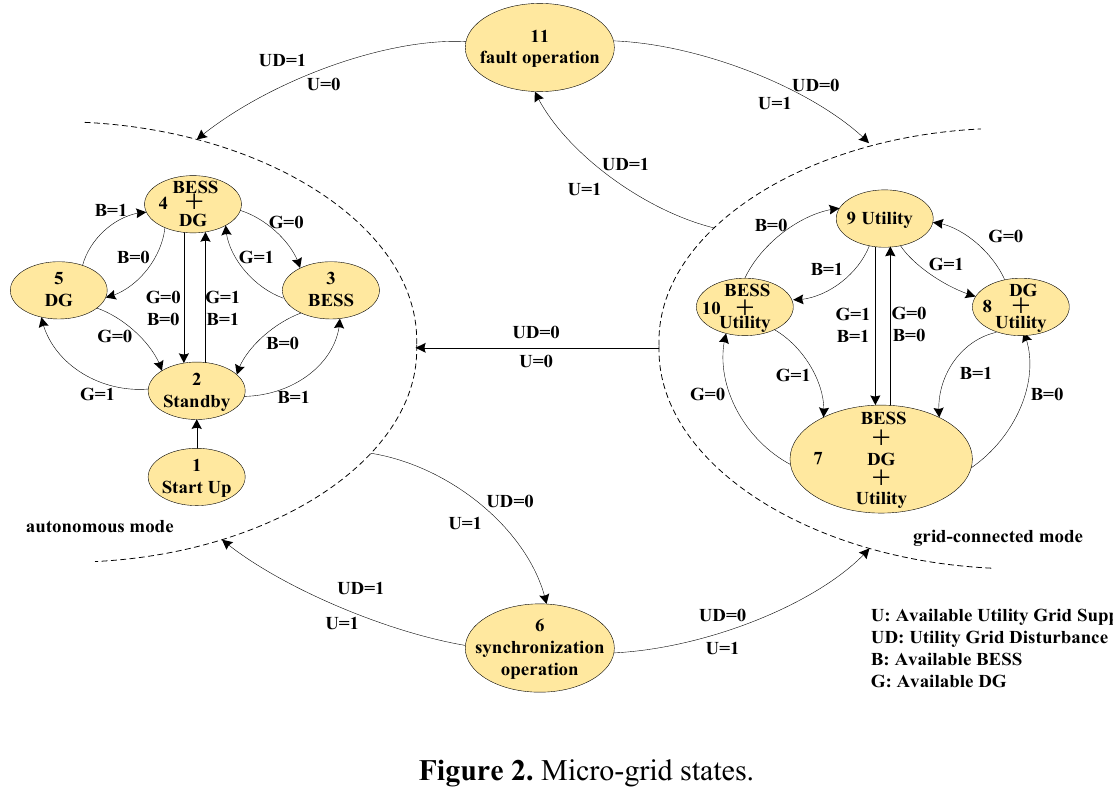
Figure 2. Micro-grid